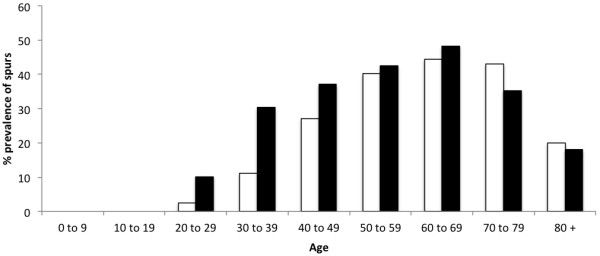
The prevalence of plantar spurs in men and women by age category. Note that the prevalence of plantar spurs were significantly higher for women (black bars) than men (white bars) in individuals <49 years of age. In both sex spurs were first seen in 20–29 years old.